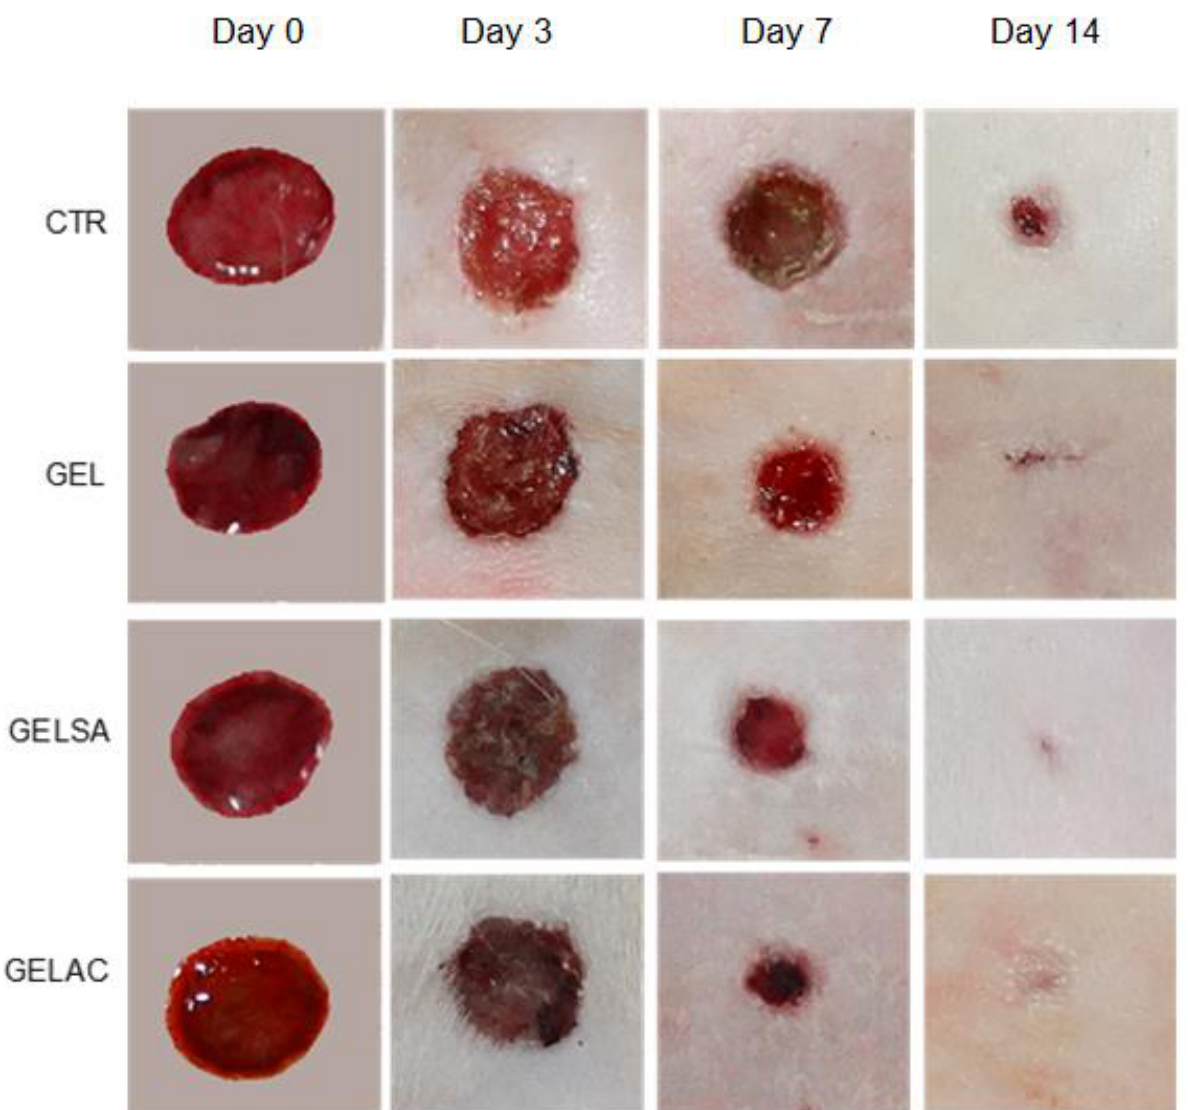
Figure 9. Photographs of the appearance of the dermal wounds during the evaluation of the retraction index of the groups: CTR (control without coverage), GEL (coverage with gelatin membrane), GELSA (gelatin membrane with S. adstringens extract), and GELAC (gelatin membrane with A. cochliacarpa extract), at 0, 3, 7, and 14 days after wound preparation.